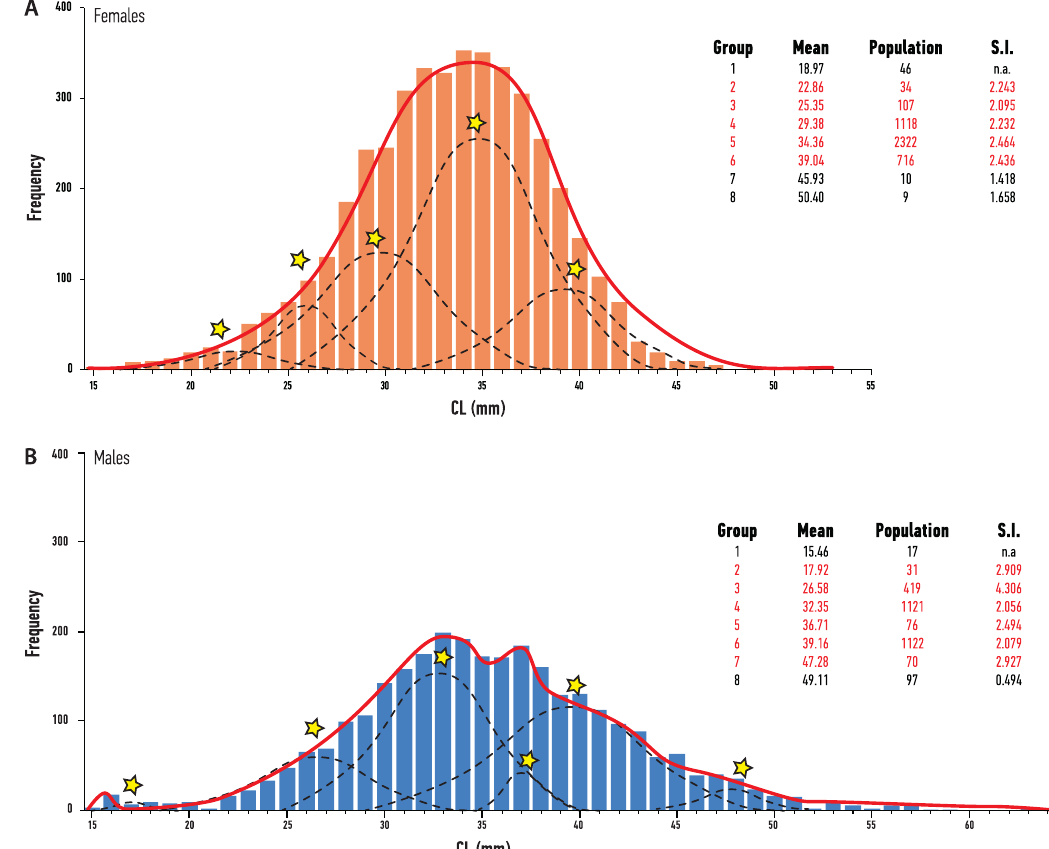
Figure 5. Modal Progression Analysis of length–frequency distributions of Carapace Length (CL) length from Nephrops ( A ) female and ( B ) male individuals. Dashed line indicates representative group of individuals belonging to the same cohorts selected in FISAT Bhattacharya’s Method. Star symbol denotes the mean CL of the representative age group. Solid line indicates better estimates of the NORMSEP analysis module. Values in table represent the mean body size (Mean) of each age group, the standard deviation (SD), population size assigned to this group (Population), and separation index (SI). Representative groups are designated with red type.